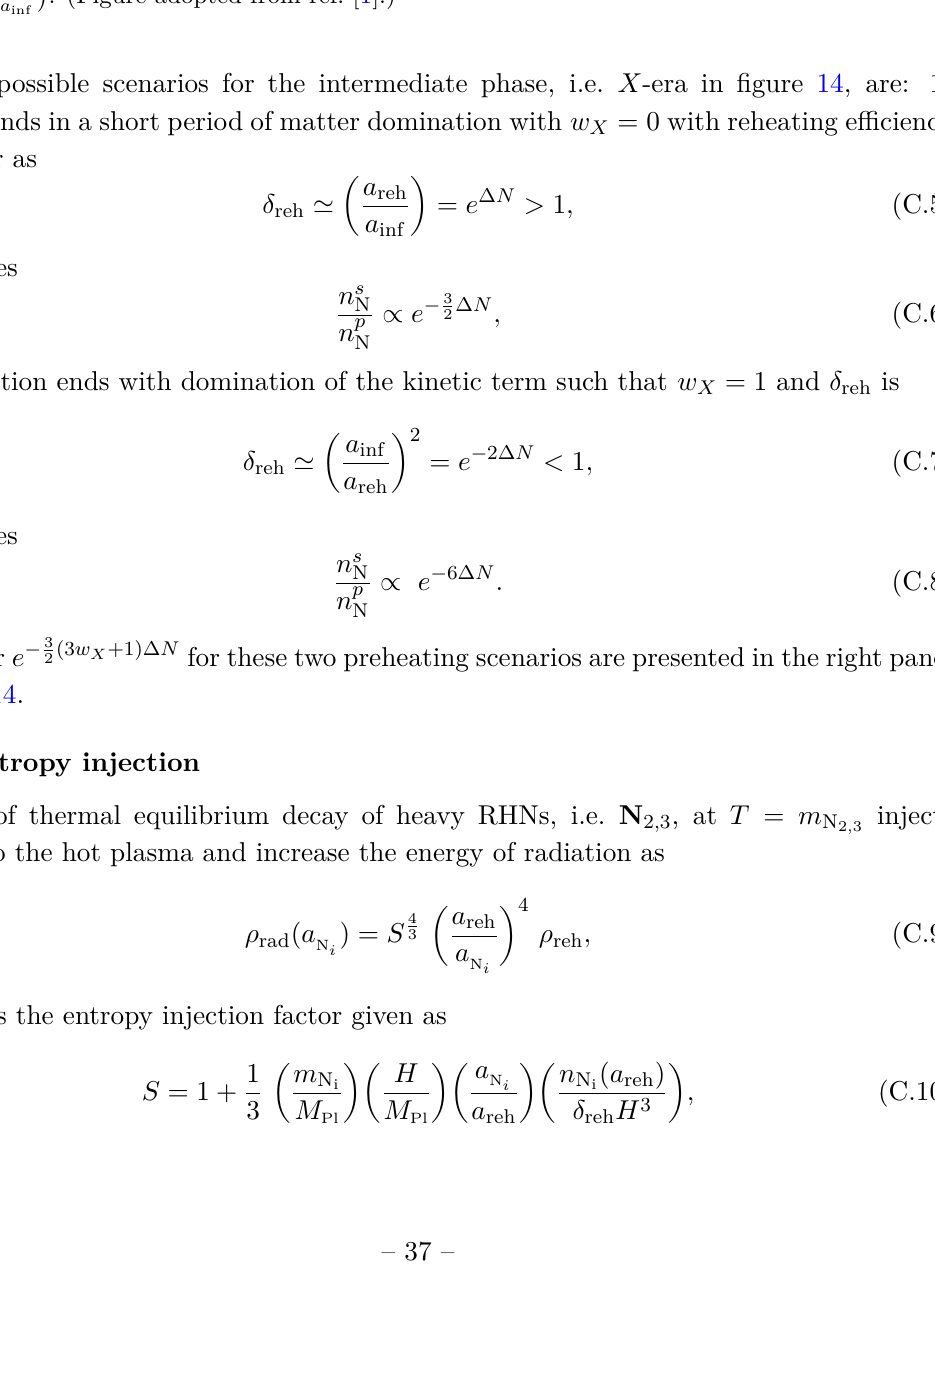
Figure 14 . Left Panel: the energy density of Universe vs scale factor. The dashed (pink) line which connects inflation to radiation era is a possible unknown intermediate phase with an average equation of state w = w . Right Panel: the prefactor e − 3 (3 w X +1)∆ N in eq. (4.13) vs 2 X (cid:1) . (Figure adopted from ref. ∆ N = ln (cid:0) a reh a inf